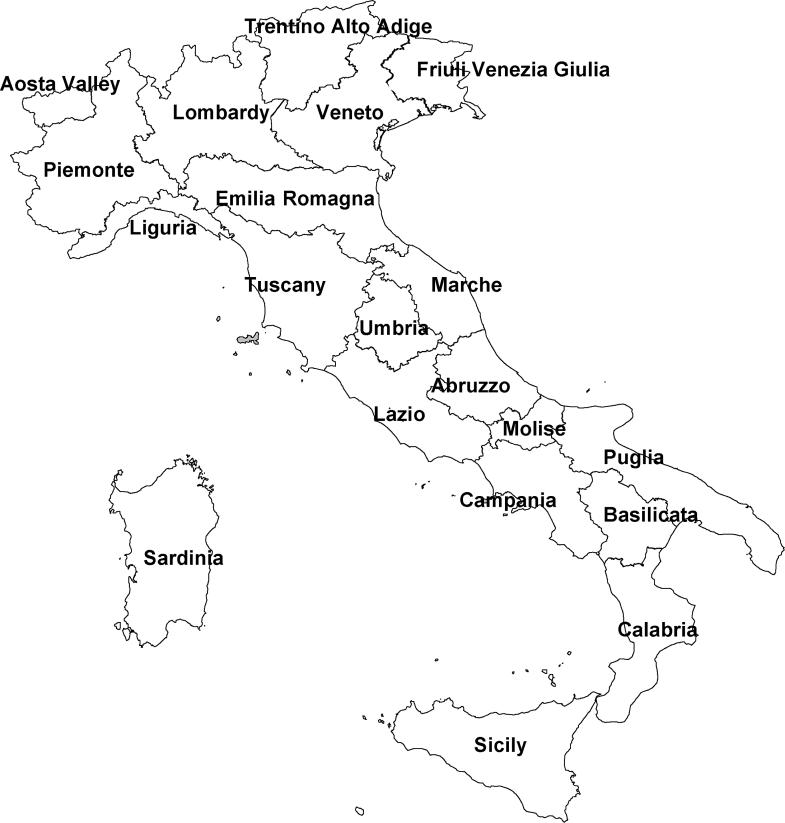
The Different Regions of Italy